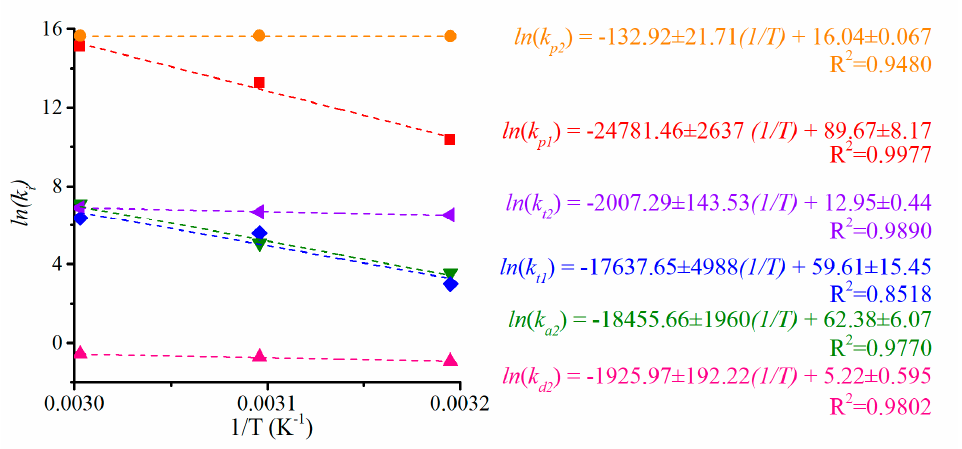
Figure 6. Arrhenius plot for a set of k i values for the ethylene coordination polymerization using a ratio B/Zr = 2.5 and their linear regressions.